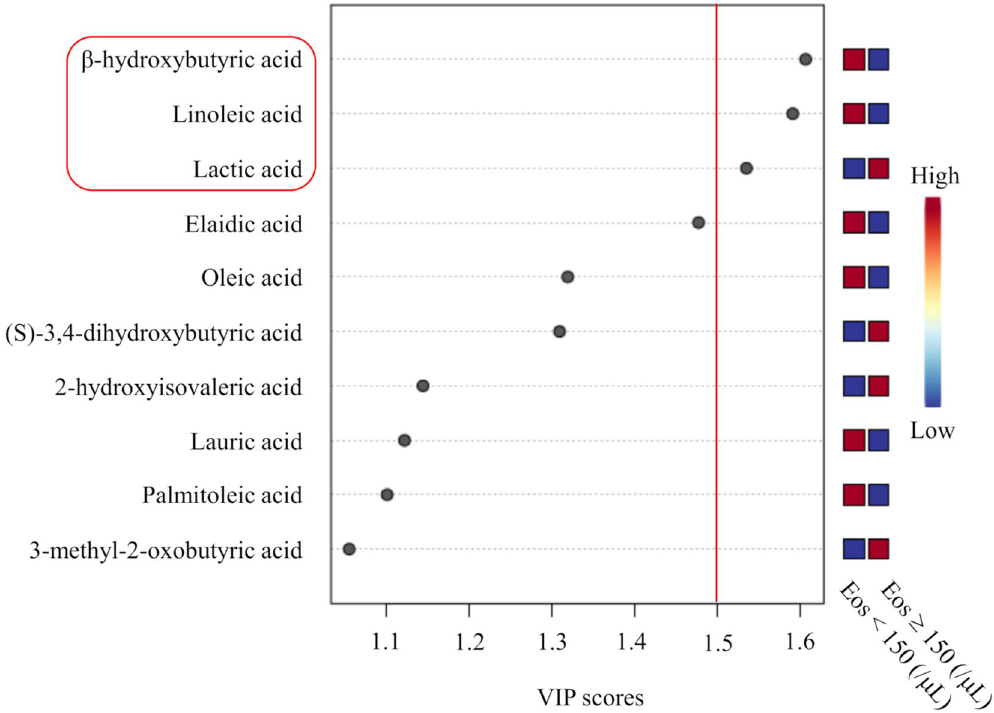
Figure 2. Partial least-squares discriminant analysis (PLS-DA). β-Hydroxybutyric acid (BHB) and linoleic acid (LA) were screened as candidates associated with lower blood eosinophil counts, with variable importance in projection (VIP) scores > 1.5. Eos blood eosinophil